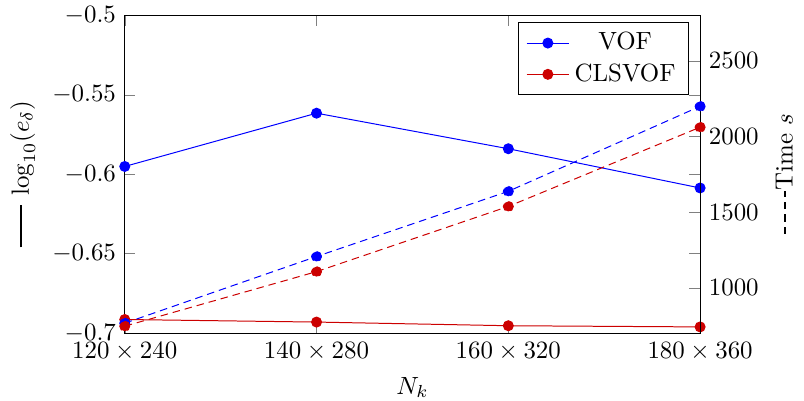
Figure 10. (Solid lines) Logarithmic representation of the error, where e δ denotes the L2 norm of the error as determined by Equation (24). (Dashed lines) Time required to simulate the vertical film condensation scenario using the VOF and CLSVOF techniques at different grid